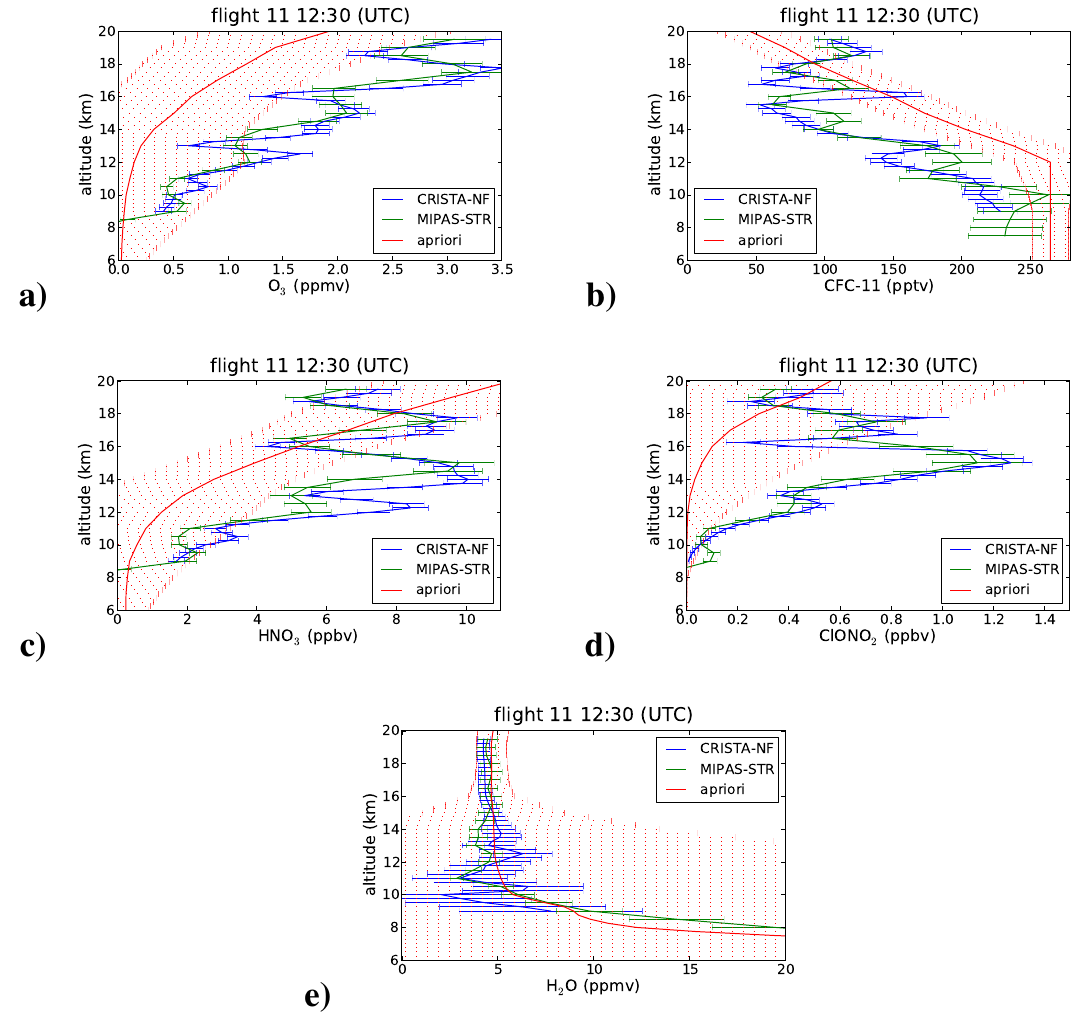
Fig. 14. Comparison between retrieval results of CRISTA-NF (blue) and MIPAS-STR (green) for a single exemplary profile taken at 12:30 UTC during flight 11. The error bars show the “total error” only. Additionally shown in red is the a priori profile and standard deviations used for the CRISTA-NF re- trievals.